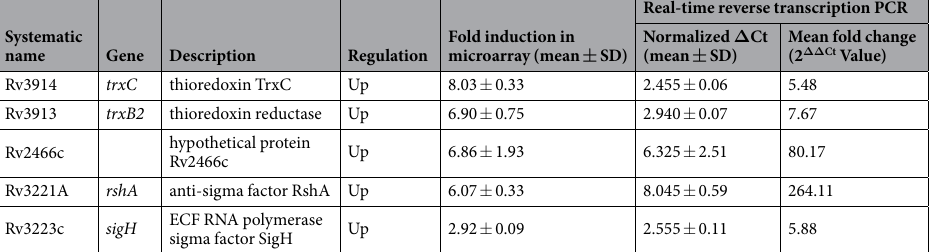
Table 3. Gene expression in M . tuberculosis treated by IMB-YH-8 with microarray and RT-PCR.